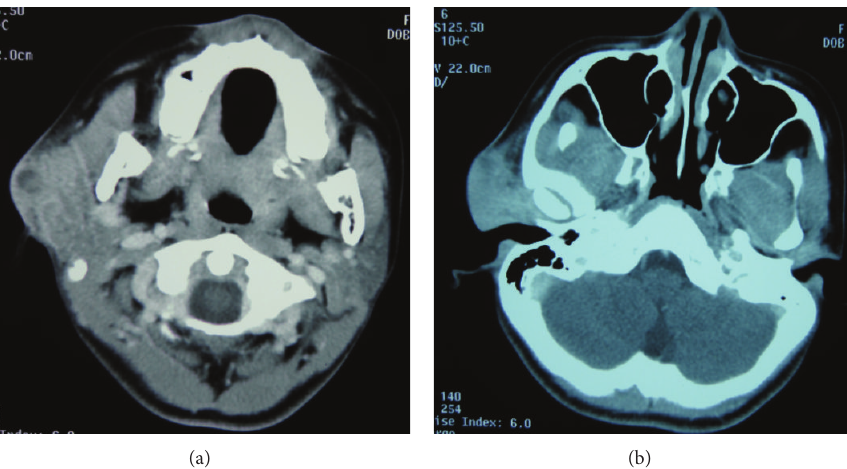
Figure 1: CT findings. (a) A 45 × 40 mm tumor is apparent in the right parotid gland. (b) Infiltration into surrounding tissues is evident, including skin, anterior wall of the external auditory meatus, masseter muscle, and temporomandibular joint.